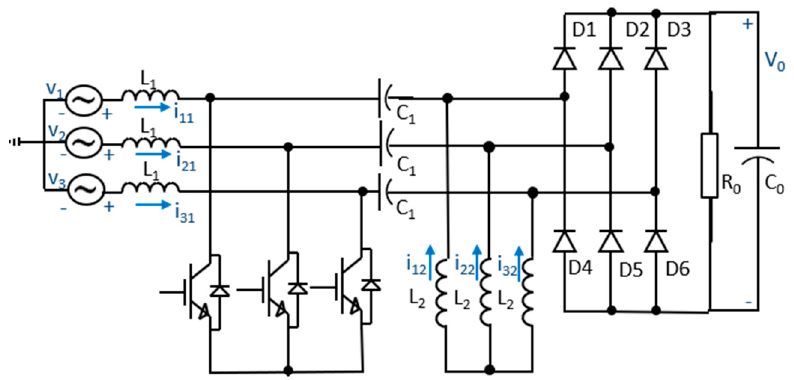
Figure 3. The proposed three-phase rectifier topology.